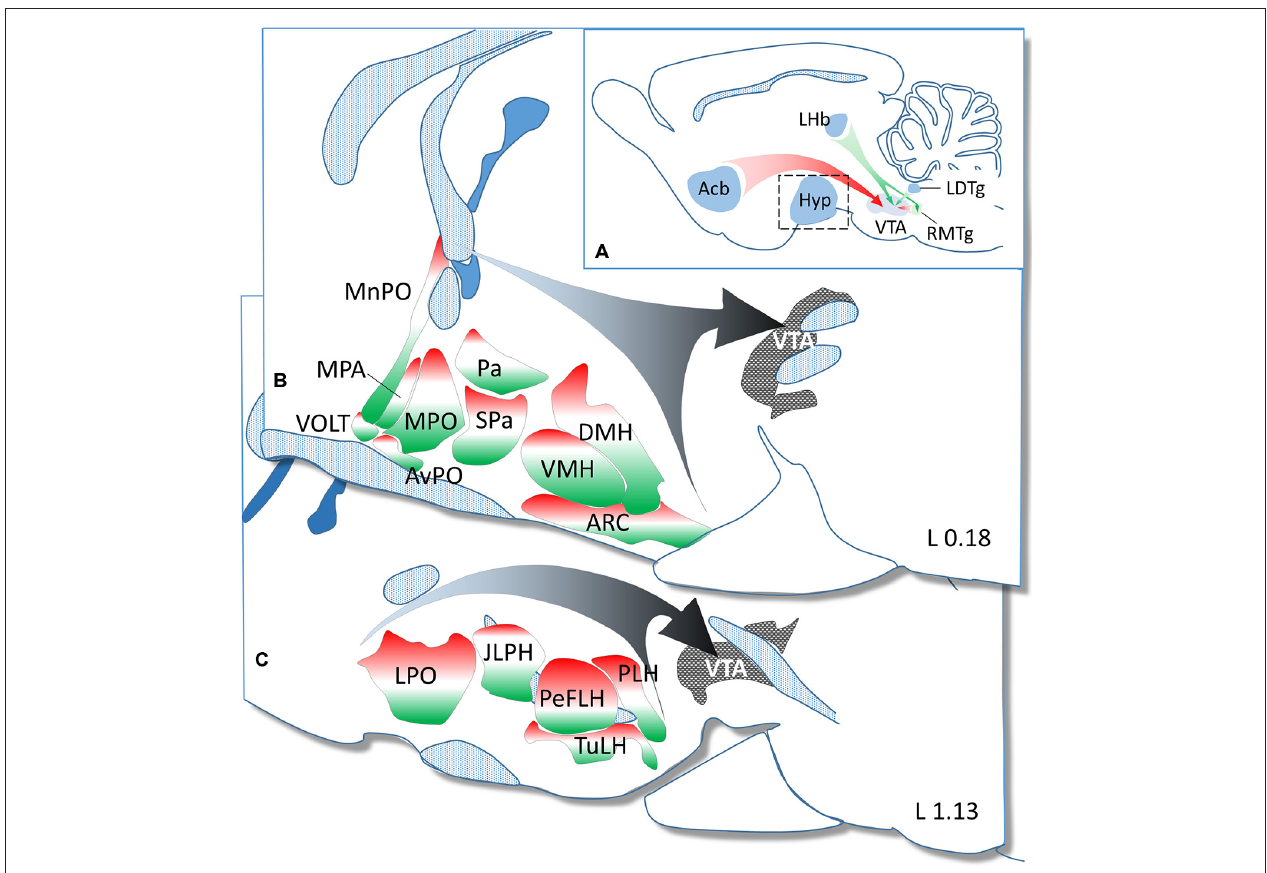
FIGURE 5 | Summary diagram to demonstrate the GABAergic and glutamatergic phenotype in neurons projecting from hypothalamic regions to the ventral tegmental area (VTA). (A) In addition to the major GABAergic (from the NAc and RMtg) and glutamatergic (from the LHb and LDtg) inputs, the hypothalamus (enframed) also represents a significant source of GABAergic and glutamatergic afferents to the VTA. The hypothalamic nuclei and regions demonstrated in two paramedian sagittal sections ( B = L 0.18 and C = L 1.13 mm) are color-coded to illustrate the relative ratio of GAD65 (red) and VGLUT2 (green) expressing neurons. The white color shows the relative ratio of neurons, which either do not express these markers or express them below the detection threshold of ISHH.